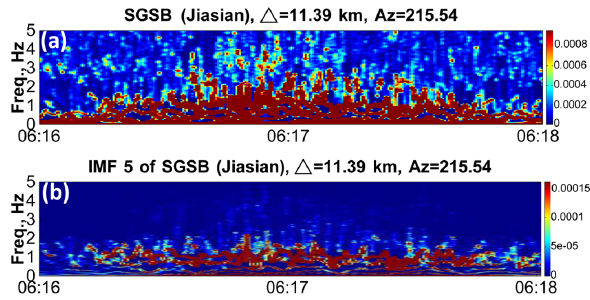
Figure 8 (a) The SGSB amplitude-time-frequency Hilbert spectrum. (b) The amplitude-time-frequency Hilbert spectrum of the SGSB IMF 5.